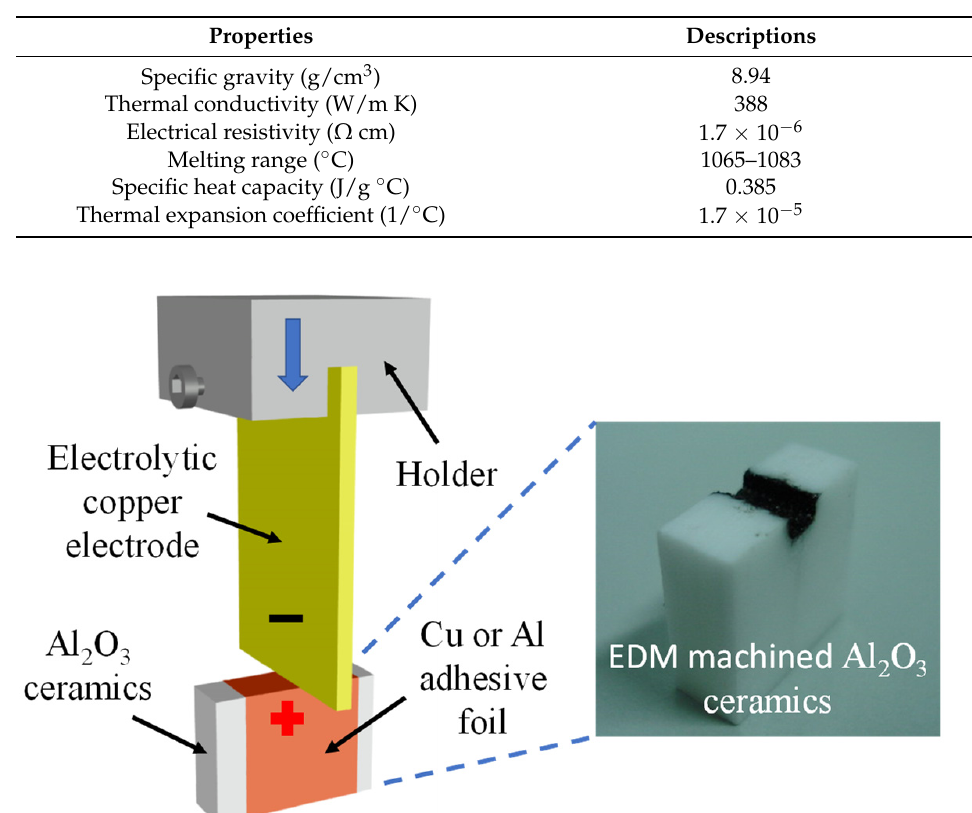
Table 2. Material properties of electrolytic copper electrode.